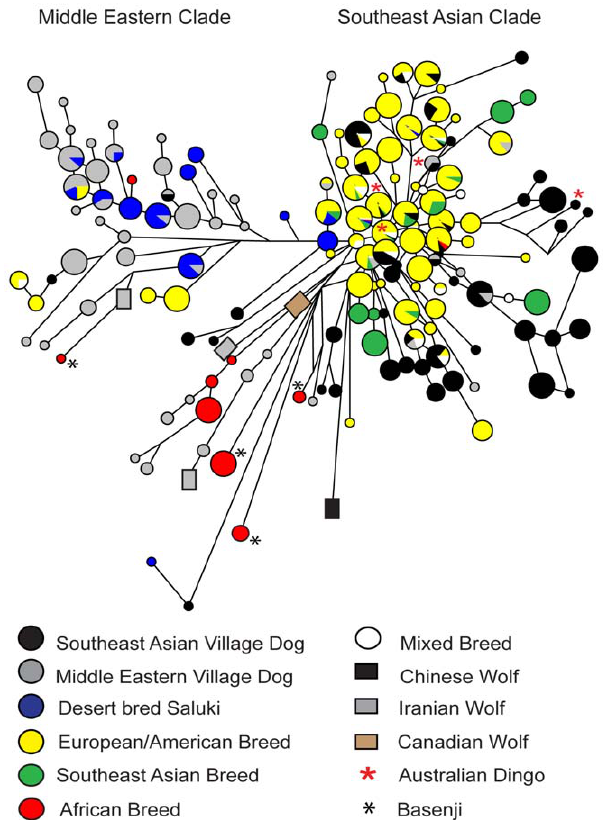
Figure 4. Y chromosome STR haplotype network indicating putative geographic origin of breed dogs. Samples include 428 village dogs, dingoes, and breed dogs genotyped in this study and 818 published breed dog haplotypes [21], color coded according to putative region of breed origin (Table S10). Size of circle is proportional to sample size, except that the largest circle represents 18–50 individuals, and line lengths are proportional to the number of mutational